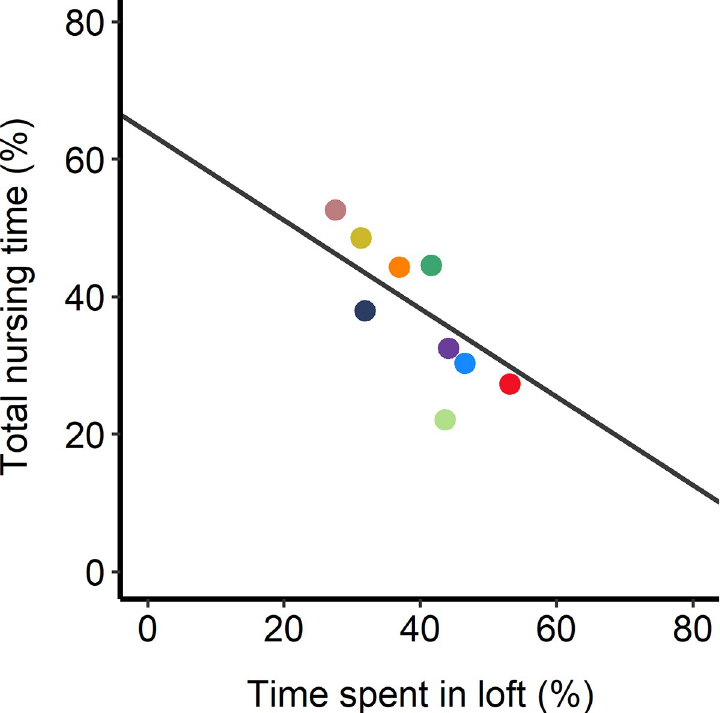
Fig 4. Correlation between total nursing time and loft use. Only rats from the loft treatment are shown. Each point represents the mean value for each rat (n = 9); individual rats are shown using different colours.